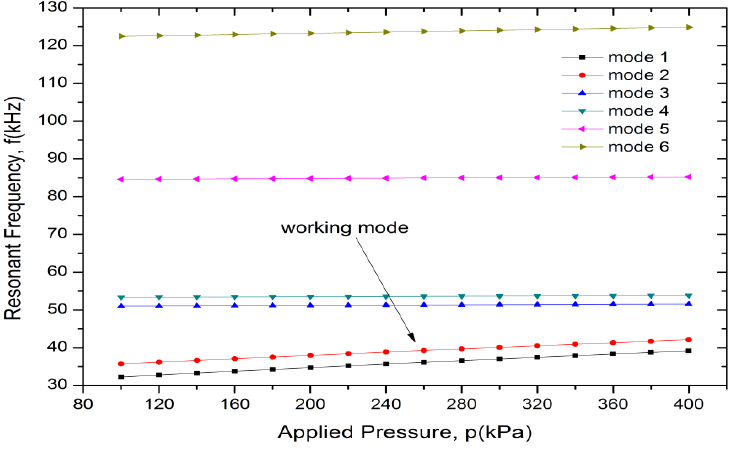
Figure 6. Resonant frequency variations of the first six vibration modes versus applied